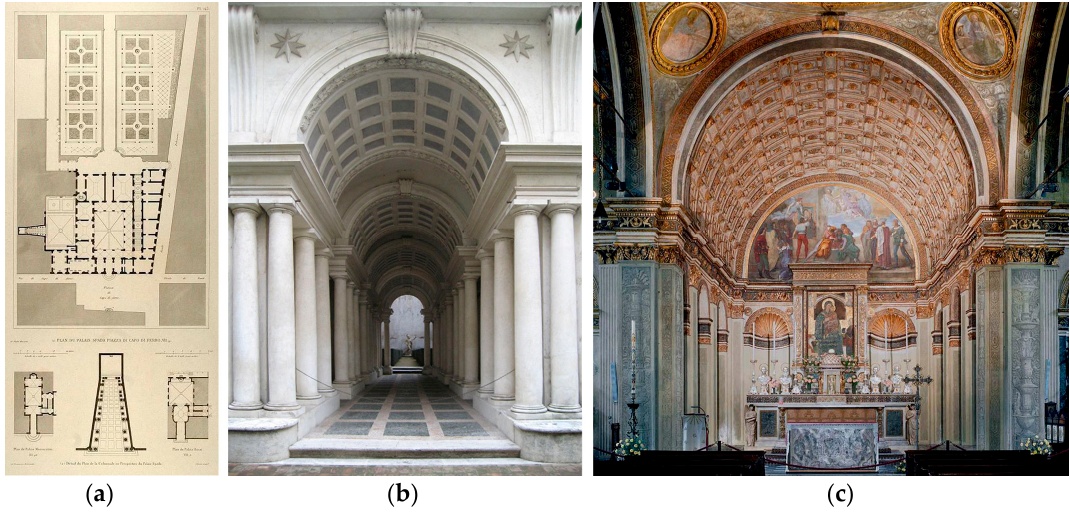
Figure 1. The perspective deception as scientifically controllable expedient: Francesco Borromini’s Galleria at Palazzo Spada, Roma, 1653. ( a ) Drawings; ( b ) Photograph; ( c ) Donato Bramante’s apse in Santa Maria presso San Satiro, Milano, 1480,